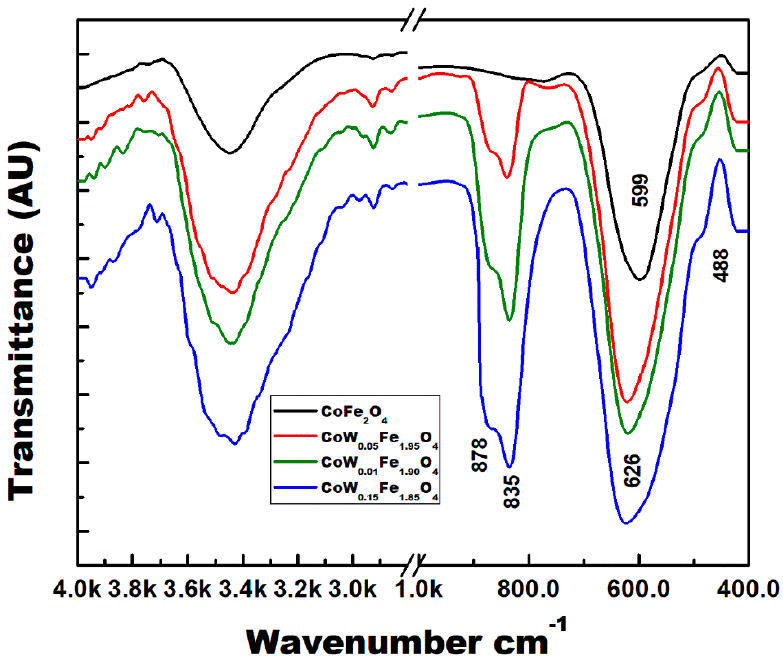
Figure 3. FTIR of CoW x Fe 2 − 2x O 4 spinel ferrite samples.